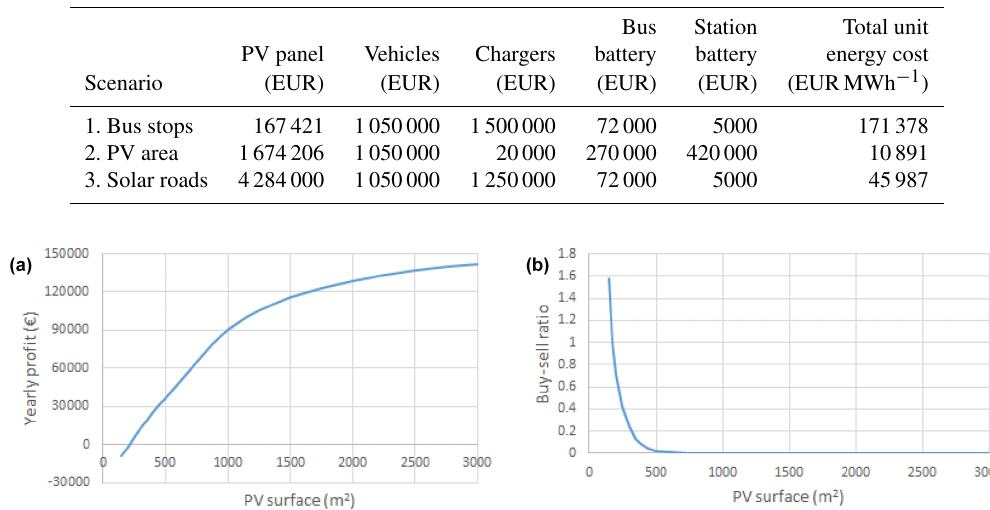
Figure 5. (a) PV surface vs expected yearly profit and (b) PV surface vs. buy-sell